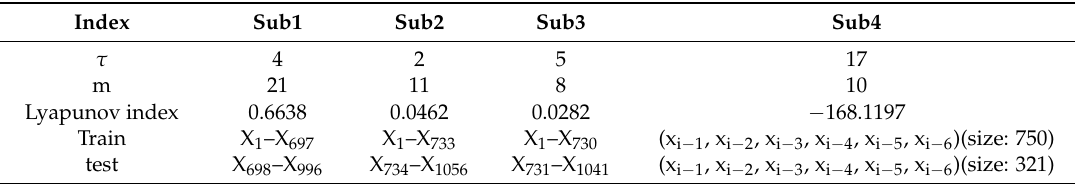
Table A7. The parameters of each subsequence decomposed by FEEMD of the Hubei carbon price.